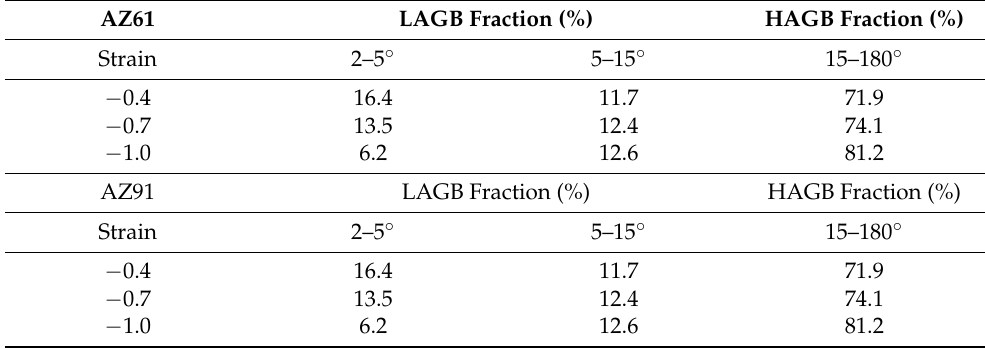
Table 2. Fraction of the boundaries with di ff erent misorientations based on the microstructure meas- ured by EBSD of AZ61 and AZ91 alloys deformed at 723 K under a strain rate of 5.0 × 10 − 2 s − 1.